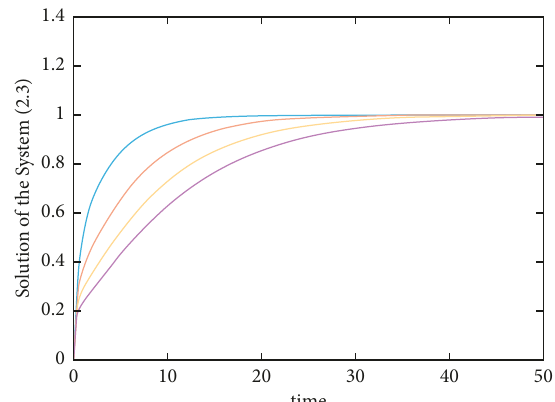
Figure 1: Trajectories of system (7) for a variety of c symbolizes the trajectory for a variety of speeds c like 2 (blue), 3 (red), 4 (yellow), and 5 (purple).